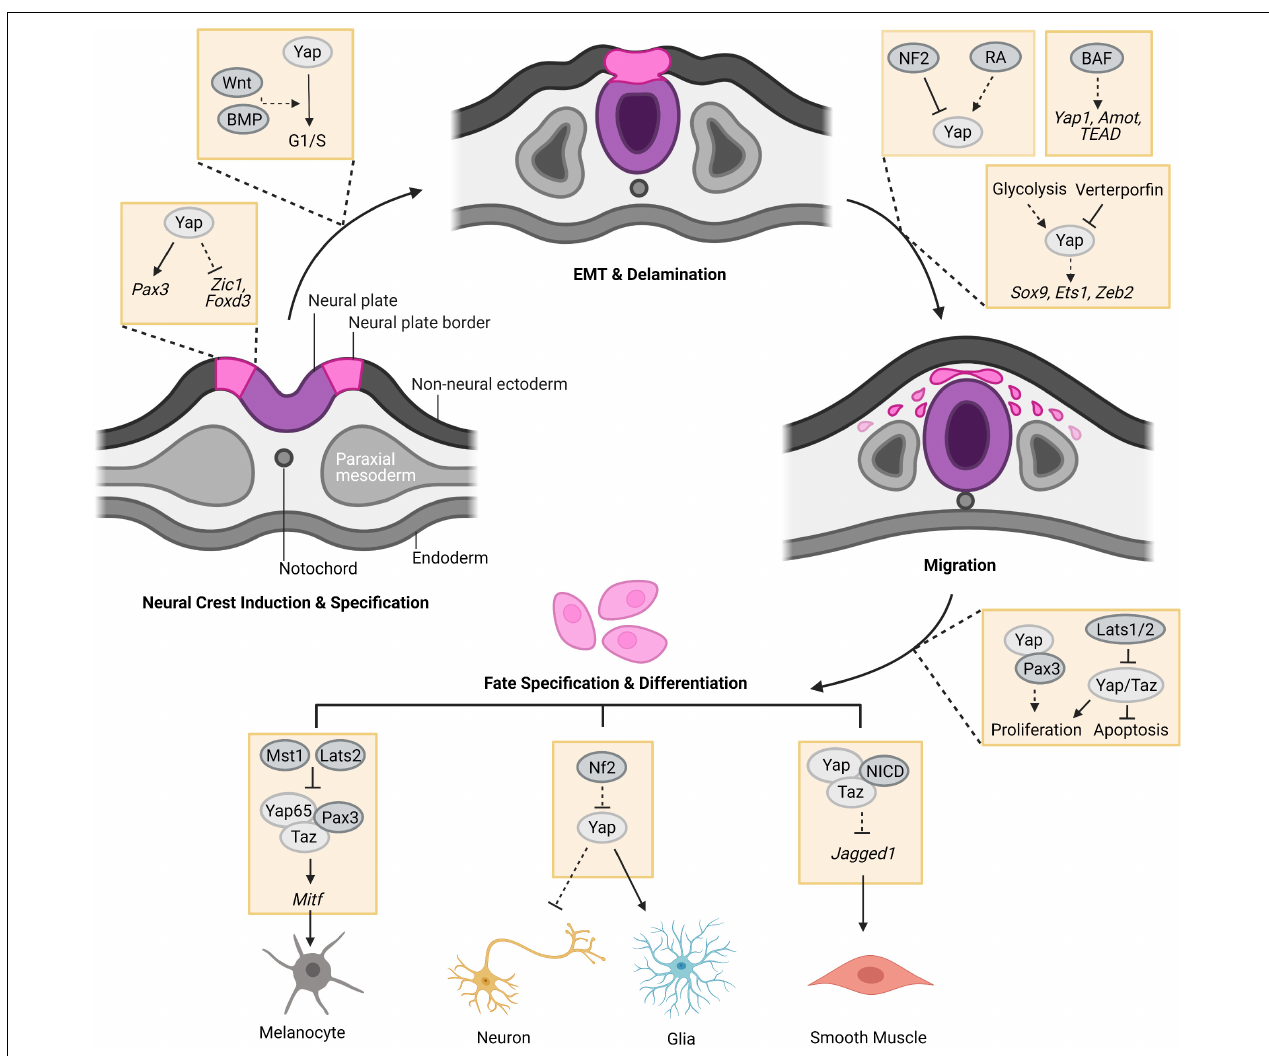
FIGURE 1 | The regulation of the Hippo-Yap pathway in neural crest (NC) development. At the stage of induction, Yap holds cells in NC progenitor state by regulating the expression of NC specifier genes, such as Pax3 , Zic1 , and Foxd3 . After induction and specification, Yap potentially co-regulates G1/S transition with Wnt and BMP to promote pre-migratory NC cell EMT and delamination from the neural tube for migration. Meanwhile, glycolytic flux favors migration of NC cells through enhancing YAP1-TEAD1 interaction to drive the expression of EMT factors, such as Sox9 , Ets1 , and Zeb2 in chick embryos. Hippo-Yap pathway may also play a role in the regulation of BAF to NC migration in mouse embryos. In addition, Yap and Taz were found to promote proliferation and survival of NC cells which could be inhibited by Hippo kinases, Lats1/2. During NC differentiation, Yap65/Taz form a complex with Pax3 to promote melanocyte differentiation of NC cells by upregulating Mitf expression, which could be repressed by Hippo kinases Mst1 and Lats2. Yap overexpression favors glia cell fate of NC cells. Accordingly, Nf2 loss-of-function boosts the cell fate of glia at the expense of neurons. The complex of Yap/Taz-NICD promotes smooth muscle cell differentiation of NC cells by inhibiting the expression of Jagged1 (Created with